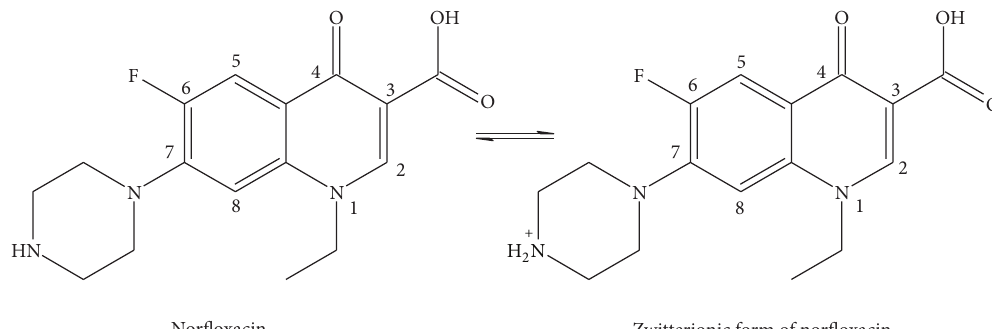
Figure 1: Molecular structure of Nor and its zwitterion.